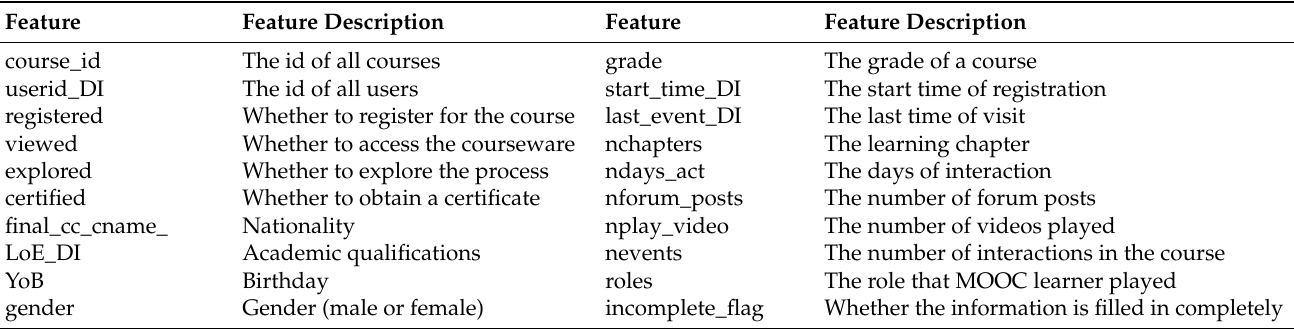
Table 1. The features table of the edX